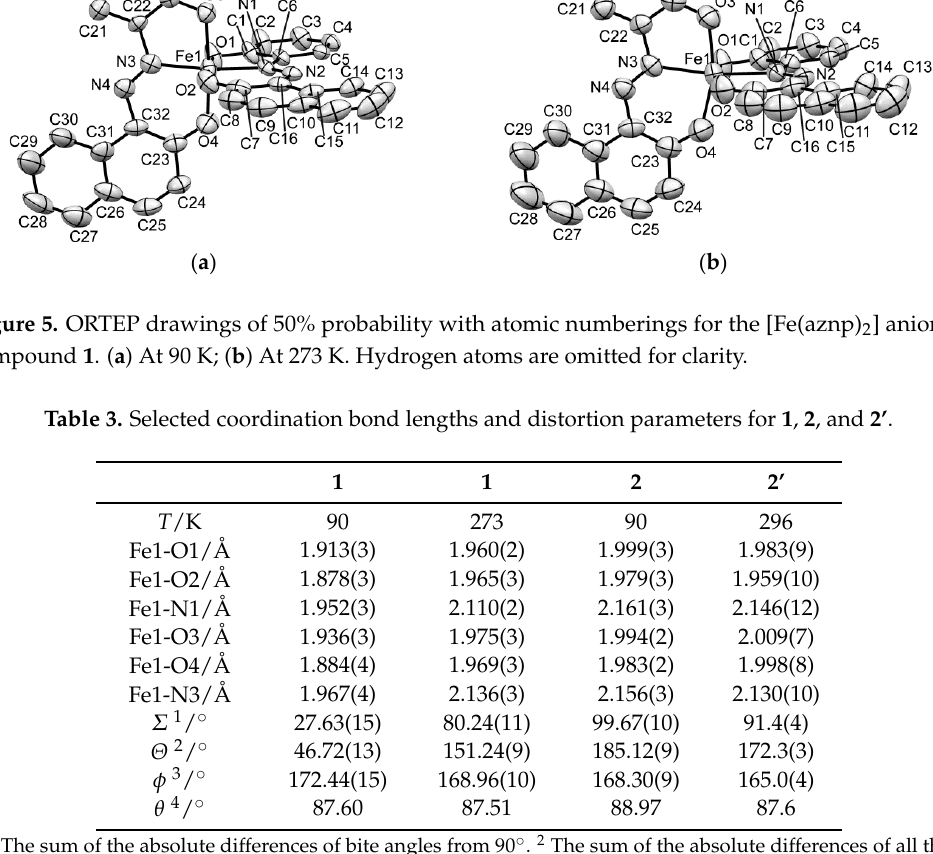
Table 3. Selected coordination bond lengths and distortion parameters for 1 , 2 , and 2’ .